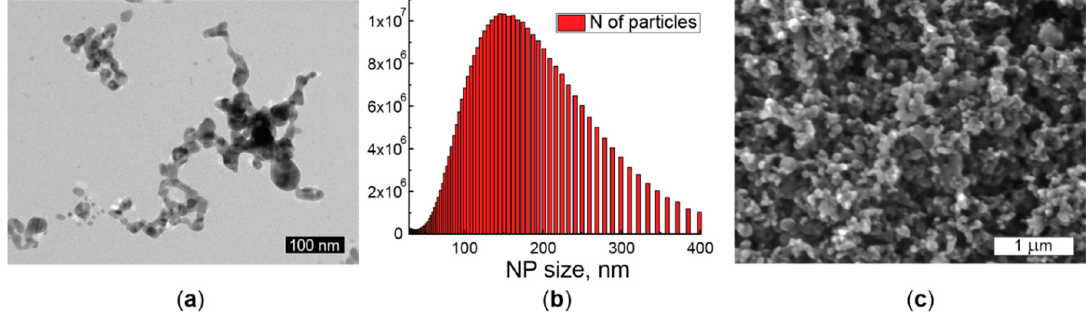
Figure 3. Characterization of primary nanoparticles: ( a ) TEM image of agglomerates consisting of primary NP; ( b ) A size distribution of the agglomerates measured in the aerosol flow by NP analyzer SMPS 3936; ( c ) The SEM image of the non-sintered NP array surface.